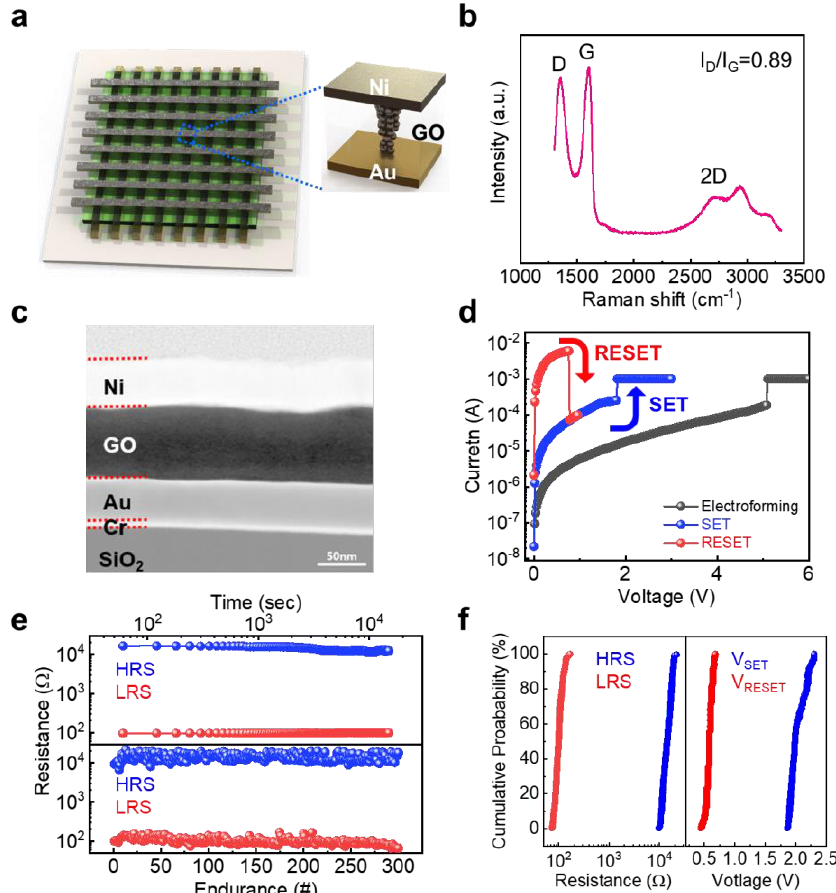
Figure 1. ( a ) Schematic illustration of GO-based memristor array. ( b ) Raman spectra of the prepared GO film. ( c ) Cross-sectional TEM image of GO-based memristor. ( d ) A typical I-V characteristic, ( e ) cycling endurance and retention characteristics, and ( f ) operational switching uniformity of HRS/LRS and SET/RESET voltages of GO-based memristor.